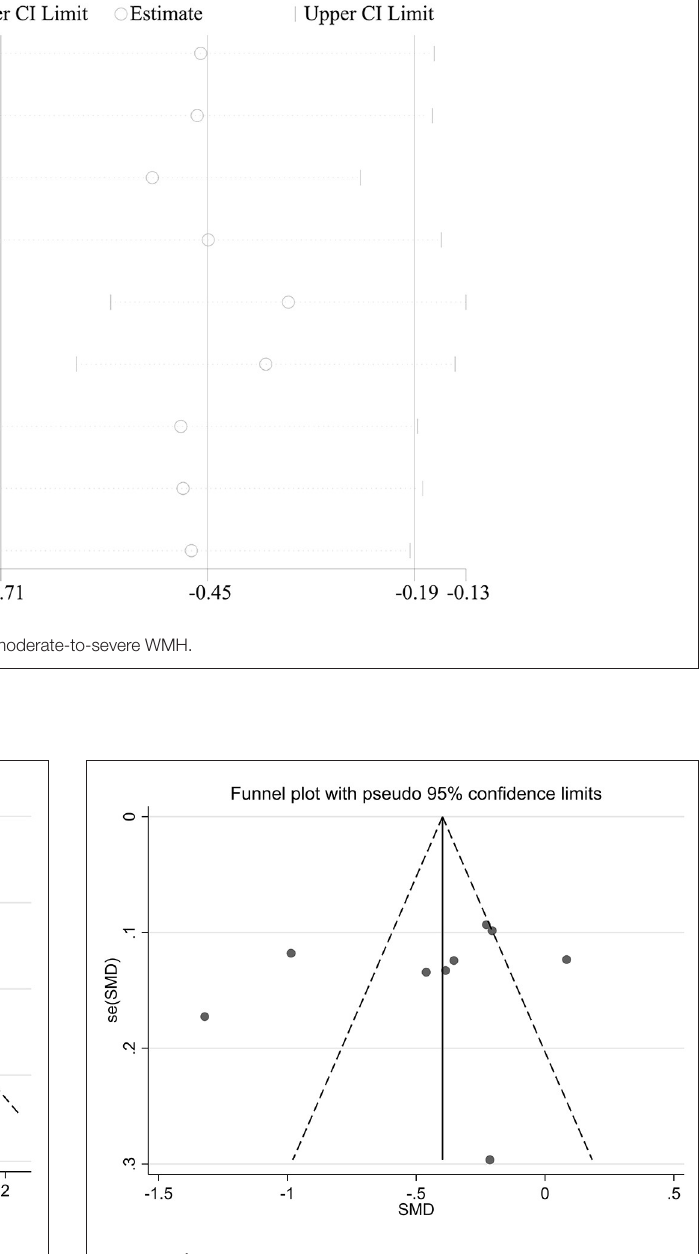
FIGURE 5 | A funnel plot of comparison of CKD vs. non-CKD. FIGURE 6 | A funnel plot of comparison of none-to-mild WMH vs. moderate-to-severe